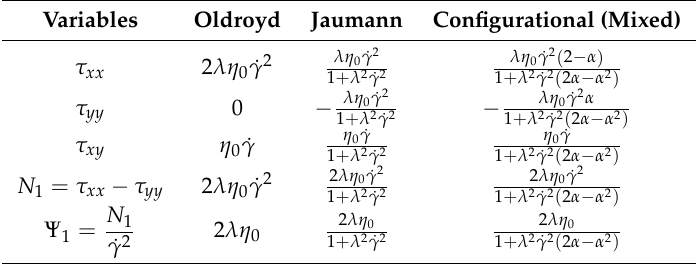
Table 1. Principal variables of the Maxwell model using different time